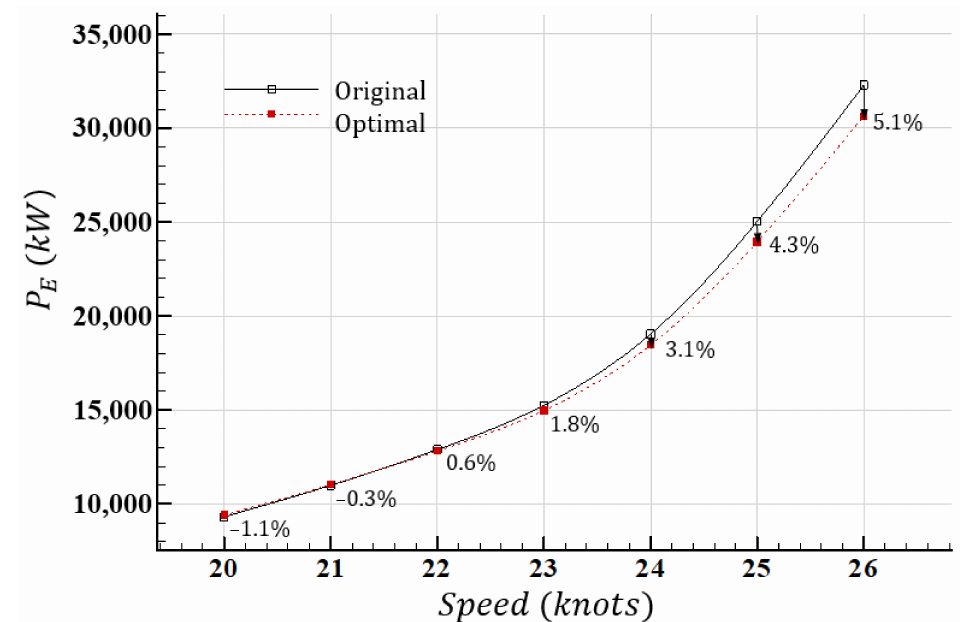
Figure 12. Comparison of the effective power between original and optimal hull